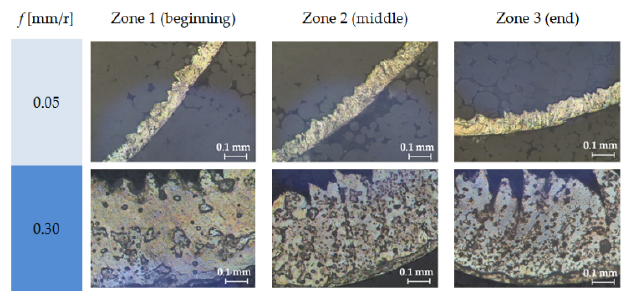
Figure 7. SOM images (200 × ) of the chip longitudinal section of UNS A92024 alloy as a function of L , for some of the f values tested.